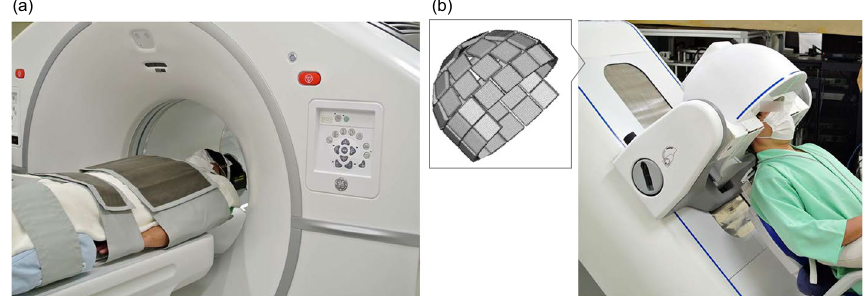
Fig. 1 Photographs of whole-body PET (Discovery MI) ( a ) and hemispherical brain PET (Vrain) with a schematic view of the detector arrangement in the expanded view ( b